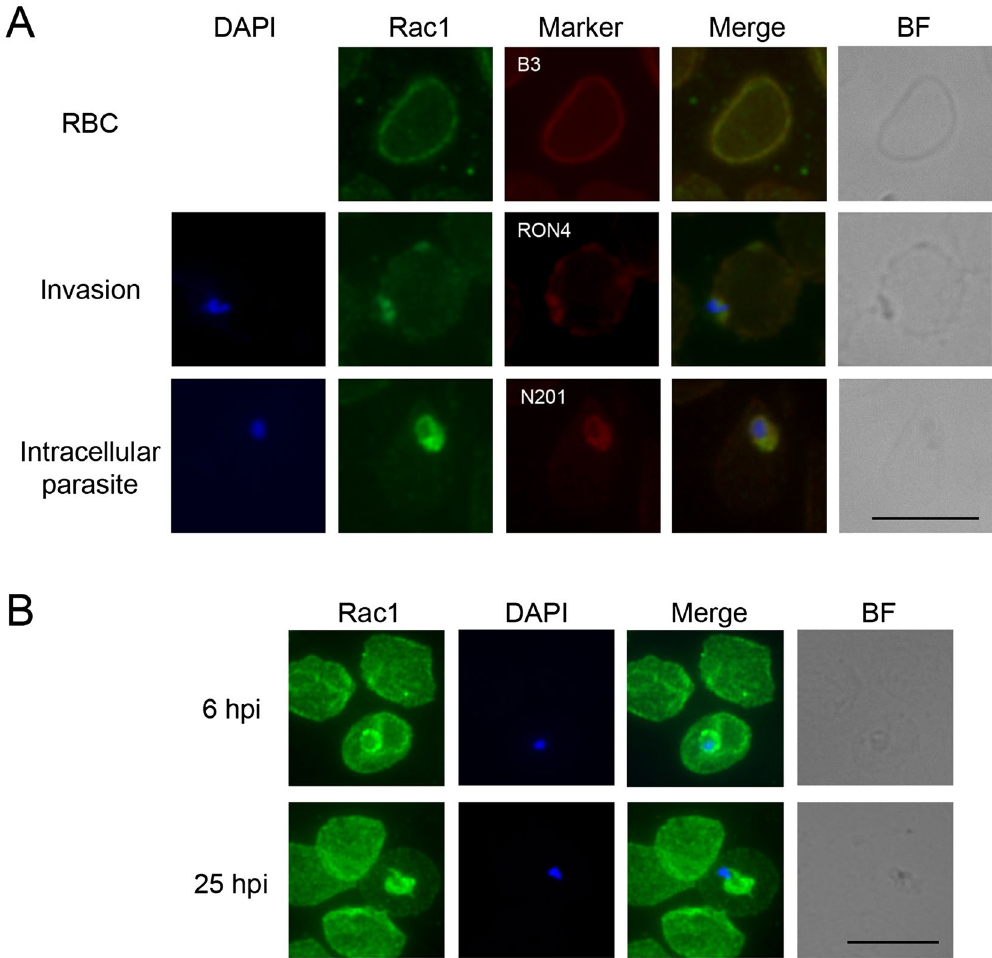
Figure 2. Rac1 subcellular localization. ( A ) IFAs of infected and non-infected human erythrocytes. Anti-Rac1 polyclonal antibody (ab#4) was used together with a primary antibody against Band3 (B3), as a marker of erythrocyte membrane, anti-RON4 antibody as a marker of the moving junction and anti-N201 as a marker of the PVM. RBC: non-infected erythrocyte. Invasion: parasite invading an erythrocyte. The nucleus